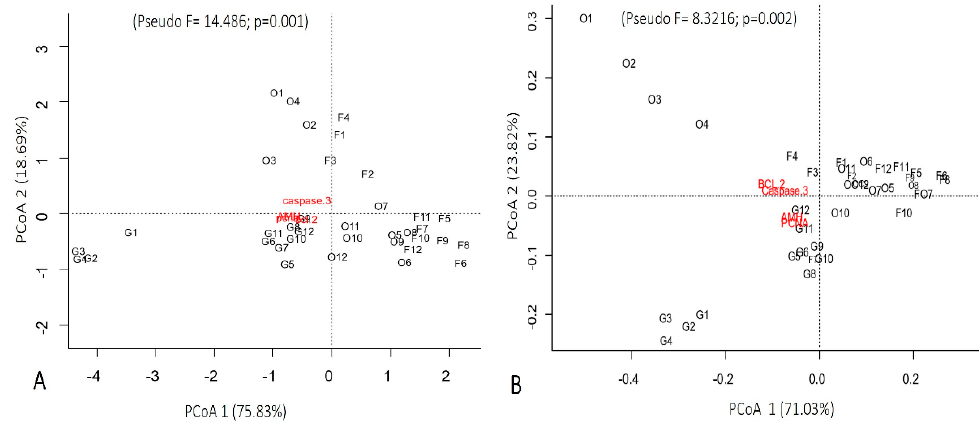
Figure 4. Immunohistochemical variables (Caspase-3, BCL-2, PCNA, and AMH), sorted by the princi-